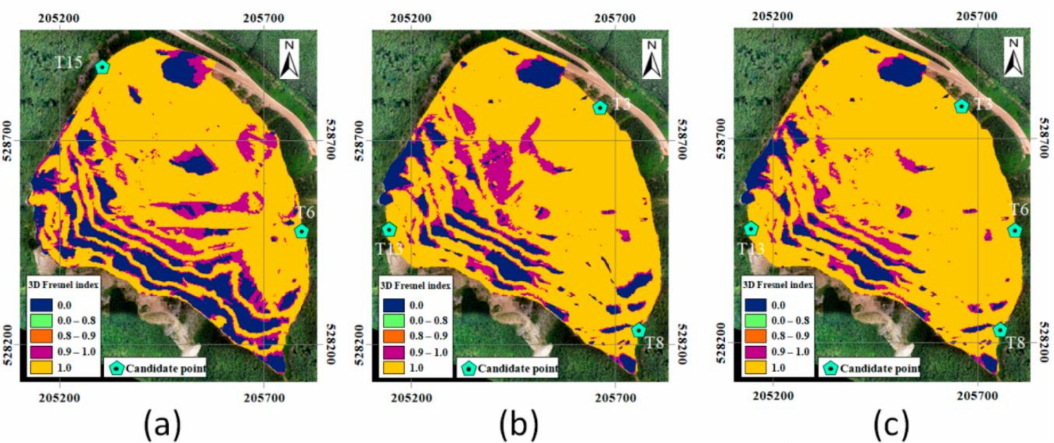
Figure 12. Three-dimensional Fresnel index overlay maps for favorable transmitter combination analysis: ( a ) combination of transmitters 6 and 15; ( b ) combination of transmitters 3, 8, and 13; and ( c ) combination of transmitters 3, 6, 8, and 13